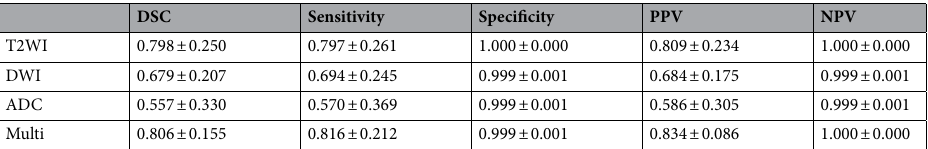
Table 3. Segmentation performance of our model for the test datasets with each magnetic resonance image sequence as the input data. Data are presented as the mean and standard deviation. ADC : apparent diffusion coefficient map, DSC : Dice similarity coefficient, DWI : diffusion-weighted image, Multi multi-sequence images (T2WI, DWI, and ADC map), NPV : negative predictive value, PPV : positive predictive value, T2WI : T2-weighted image.